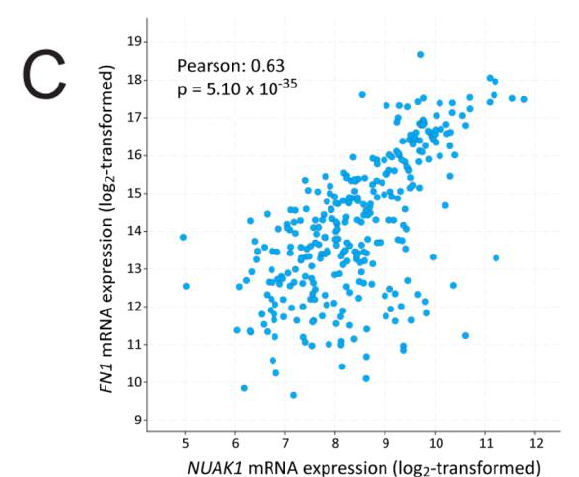
Figure 5. NUAK1 loss in OVCAR8 cells extends survival in xenografted mice. ( A ) Survival analysis for OVCAR8- NUAK1 KO and OVCAR8 xenografts into female NOD / SCID mice (n = 6). Log-rank test was performed to compare OVCAR8 and OVCAR8– NUAK1 KO curves. ( B ) Histological analysis of xenografted tumours. Serial sections were stained with hematoxylin and eosin (H&E) or immune-stained for fibronectin as indicated. Black boxes in the low-magnification H&E images encompass an area of interest represented in the high-magnification images. Scale bars represent 4 mm and 200 µ m, respectively. ( C ) Correlation analysis between NUAK1 and FN1 mRNA expression (log 2 -transformed) in the TCGA Ovarian Serous Cystadenocarcinoma Firehose Legacy dataset (cBioPortal). Pearson correlation coe ffi cient and p value are